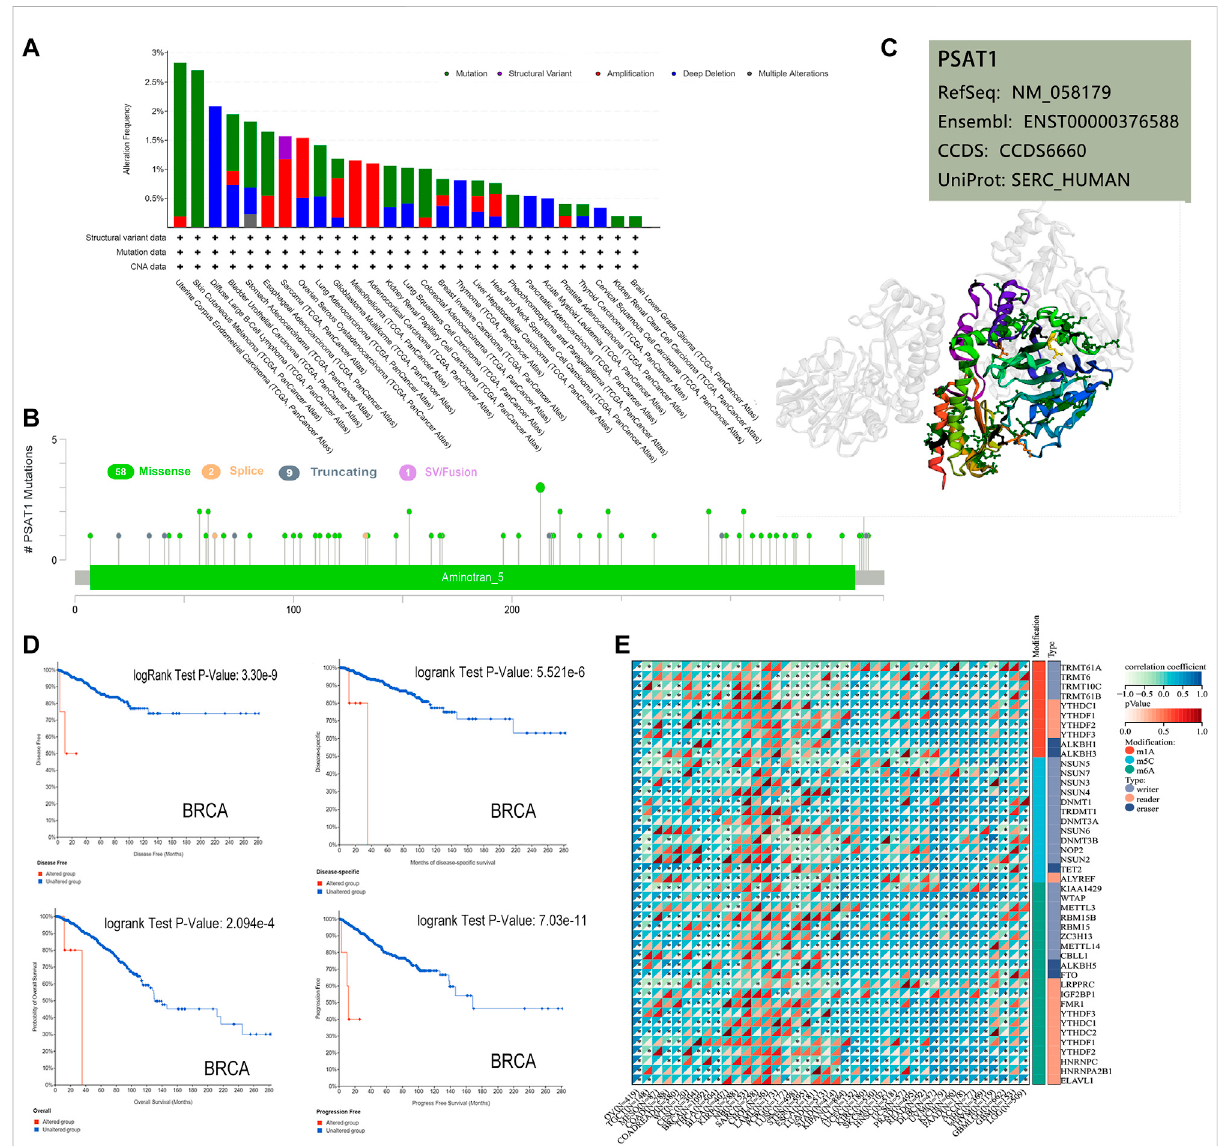
FIGURE 3 Mutation and RNA modi fi ed features of PSAT1 in cancers of TCGA. (A) Bar plot of PSAT1 alteration frequency with mutation type and (B) mutation site through cBioPortal tool. (C) The highest alteration frequency (R213HC) in the 3D structure of PSAT1 was displayed. (D) Analyzing the relationship between different mutation states and overall, disease-speci fi c, disease-free and progression-free survival using the cBioPortal tool. (E) Correlation analyses of PSAT1 and three kinds of RNA modi fi ed (m1A (Carvalho-Silva et al., 2019), m5C (Nombela et al., 2021), m6A (Vié et al., 2008)) marker genes in Pan-Cancer. * p <